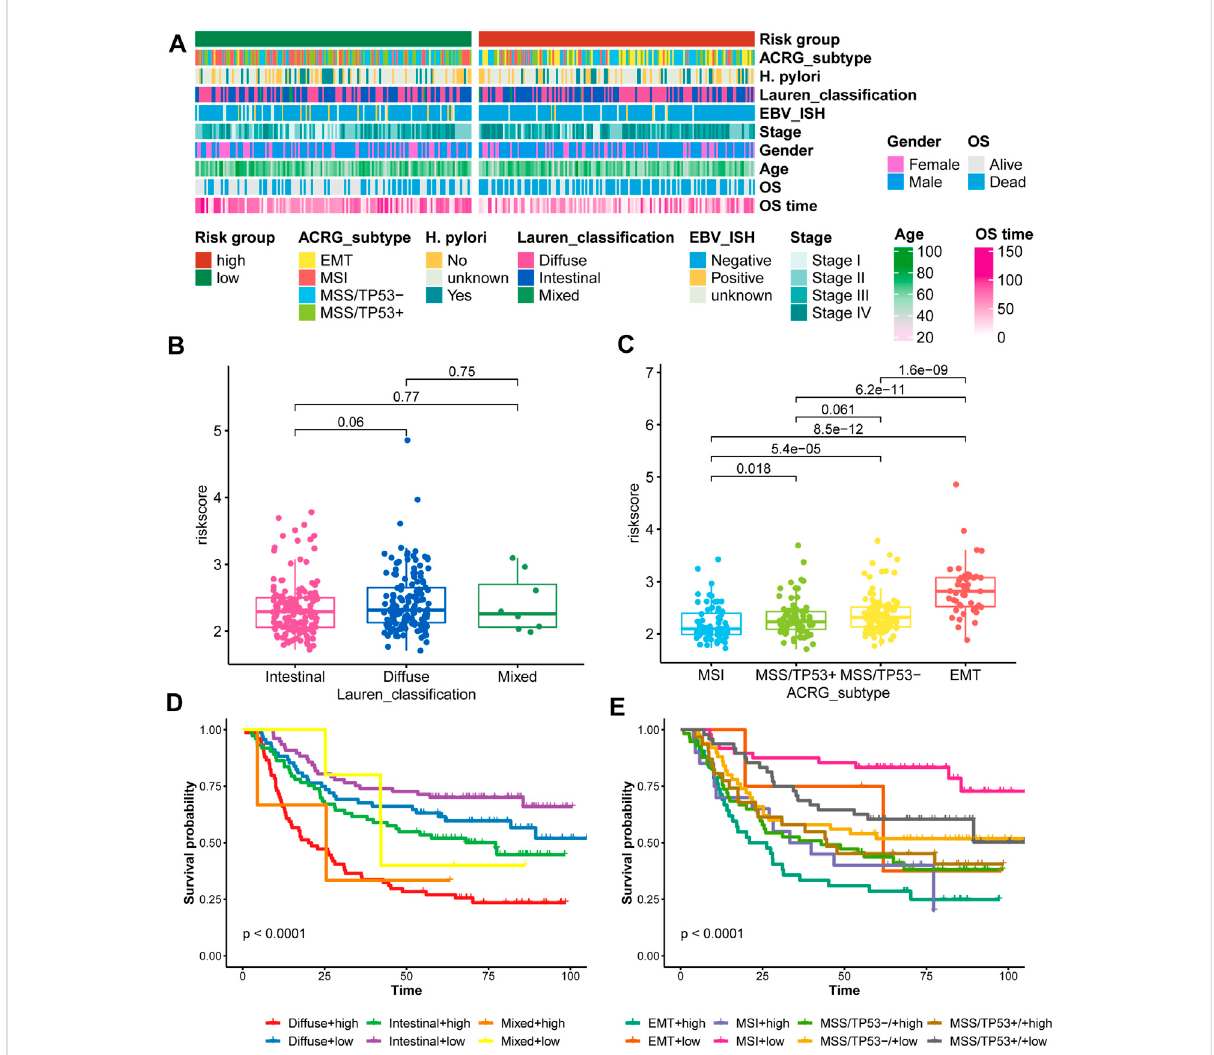
FIGURE 9 Comparisonofthenine-consensusprognosticgenesignatureandproposedmolecularsubtypes. (A) ,Heatmapshowingthemolecularfeatures and clinical features in low- and high-risk subgroups; (B) , Box plot showing the comparison of risk score between Lauren classi fi cation subgroups; (C) , Box plot showing the comparison of risk score between ACRG subtypes; (D) , K-M plot showing the diverse overall survival between Lauren classi fi cation plus risk subgroups; (E) , K-M plot showing the diverse overall survival between ACRG subtypes plus risk